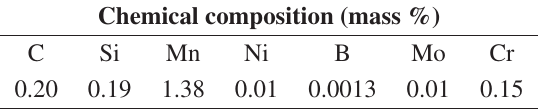
Table 1. Chemical composition tested